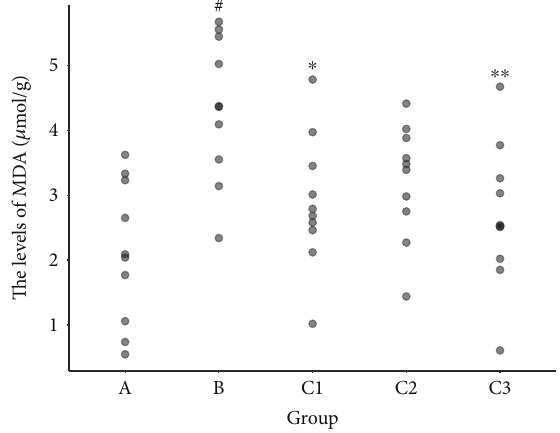
Figure 4: Infarct areas of the brain tissue within 5 days after reperfusion, staining by triphenyltetrazolium chloride. Group A: sham-operated; group B: control; group C1: pretreatment; group C2: treatment; group C3: pretreatment +treatment.